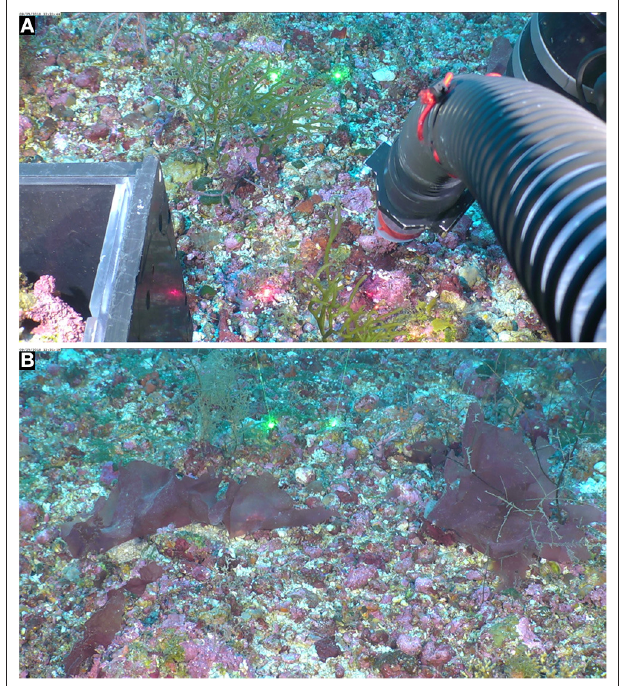
FIGURE 2 | Rhodoliths form the substratum for attached fleshy and crustose red, brown, and green seaweeds. Mohawk ROV photos taken on 25 Sept. 2018 in West Flower Garden Bank, FGBNMS. (A) 27 ◦ 52’7.2732“N, 93 ◦ 51’34.4088”W, 58.8m depth (Dive 706_0238_122144). The visible macroscopic seaweed is the green alga Codium isthmocladum Vickers (Codiaceae, Bryopsidales). (B) 27 ◦ 52’ 7.1682“N, 93 ◦ 51’34.185”W, 58.8m depth (Dive 706_0268_123120). The visible fleshy macroscopic red algal blades are the red alga Anatheca sp. (Areschougiaceae, Gigartinales). Space between spot lasers =